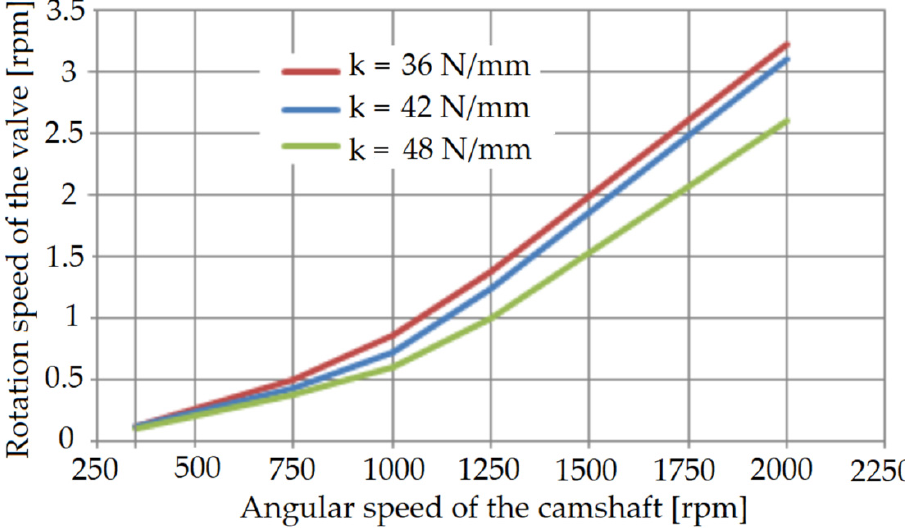
Figure 22. The influence of the spring stiffness coefficient on the speed of rotation of the valve.